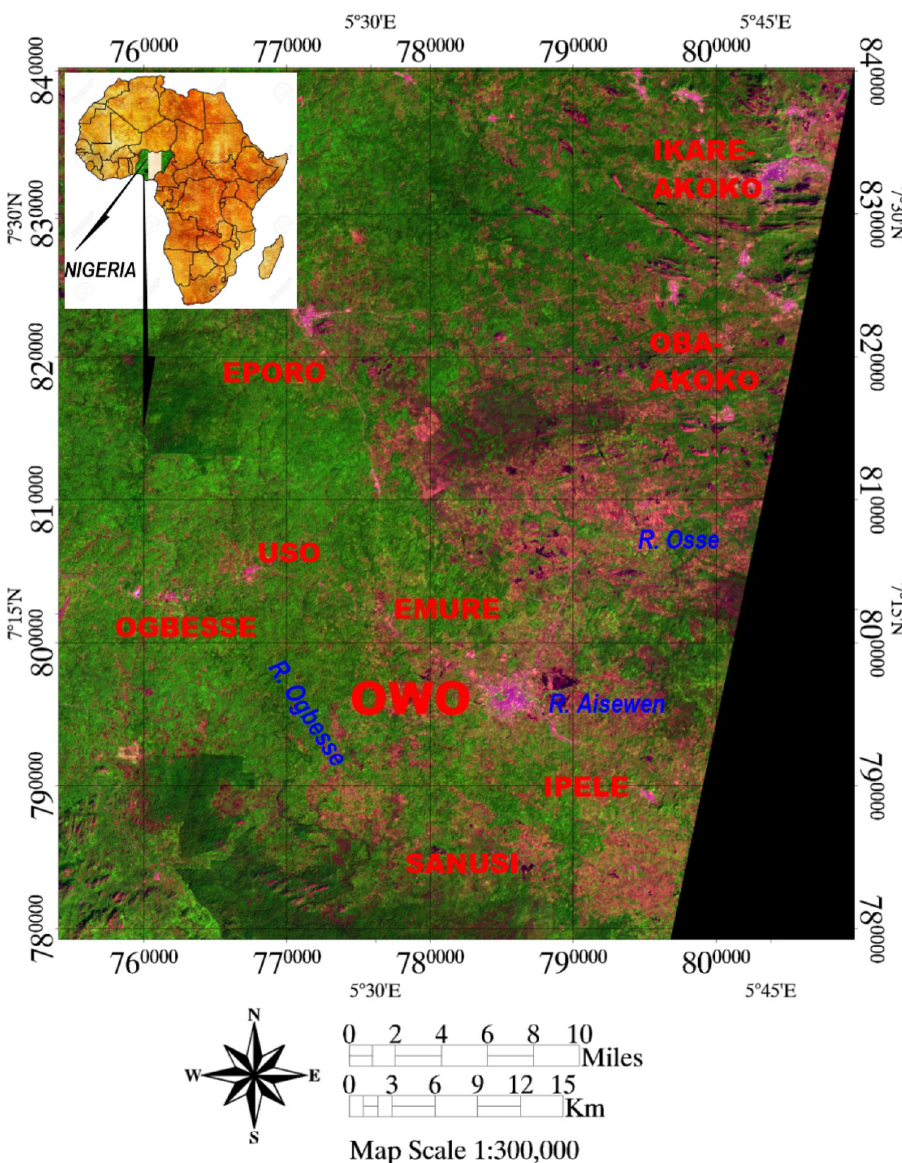
Fig. 1 Map of the